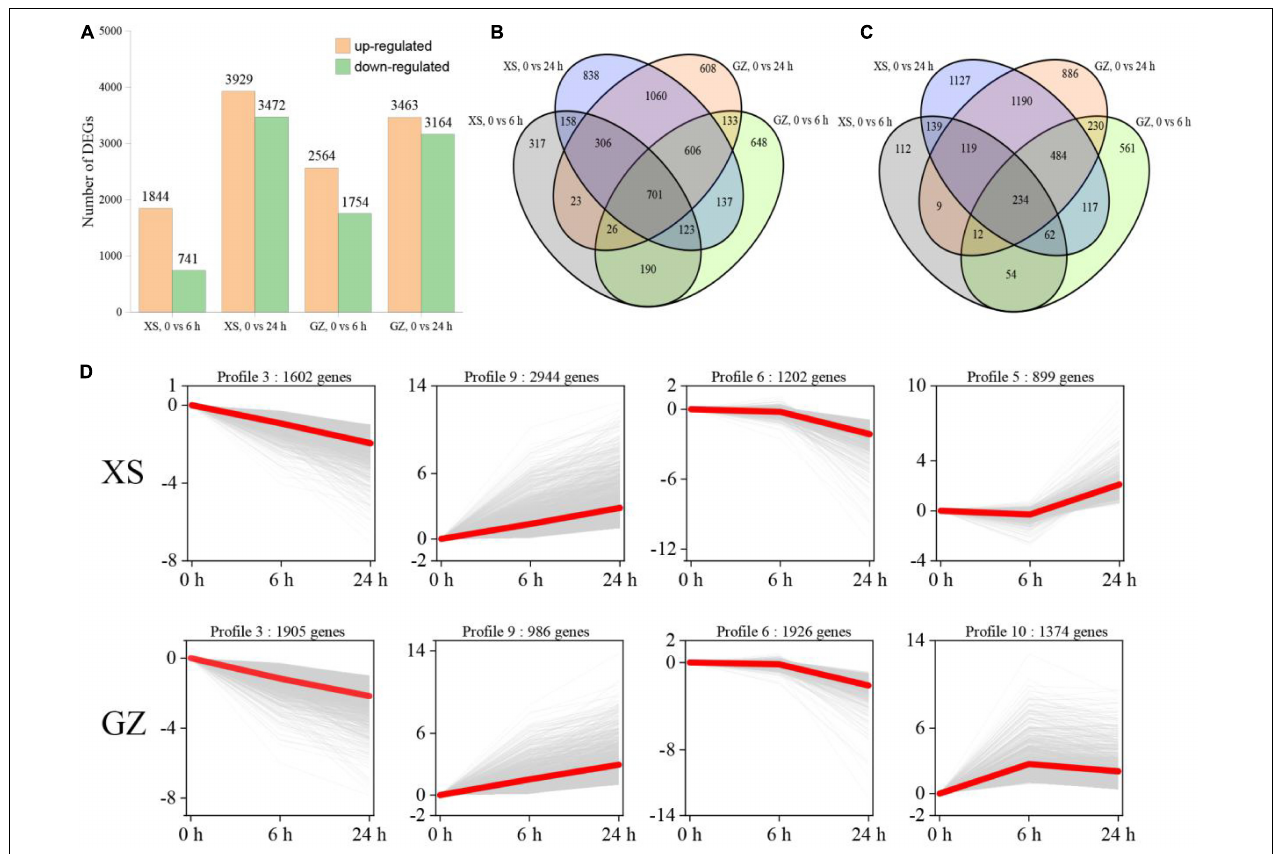
FIGURE 2 | Gene expression profile of different pepper genotypes in response to cold stress. (A) Total number of upregulated and downregulated differentially expressed genes (DEGs). (B) Venn diagram of upregulated DEGs. (C) Venn diagram of downregulated DEGs. (D) Patterns of DEGs expressions across three time points in cold-sensitive cultivar XS and cold-tolerant cultivar GZ. In each frame, the gray lines represent the gene expression pattern, and the red lines represent the expression tendency of all the genes. The number of genes belonging to each pattern is given above the